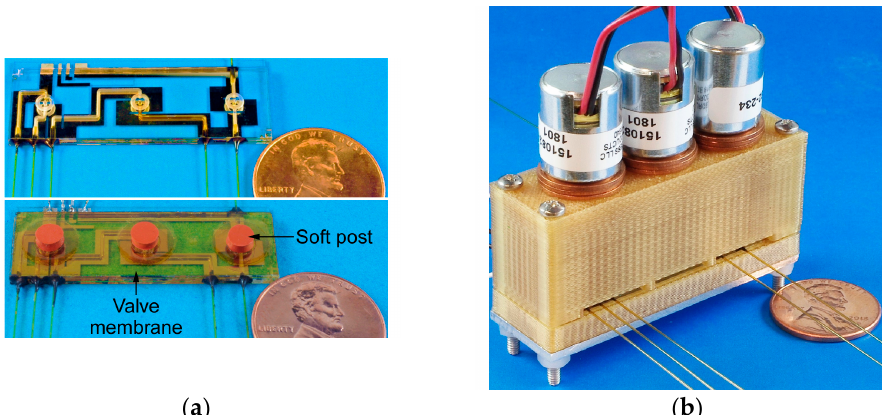
Figure 4. ( a ) Photographs of the fluidic die stack prior to and following the assembly of the valve membrane and soft post. ( b ) Final view of the fully assembled microvalve module.